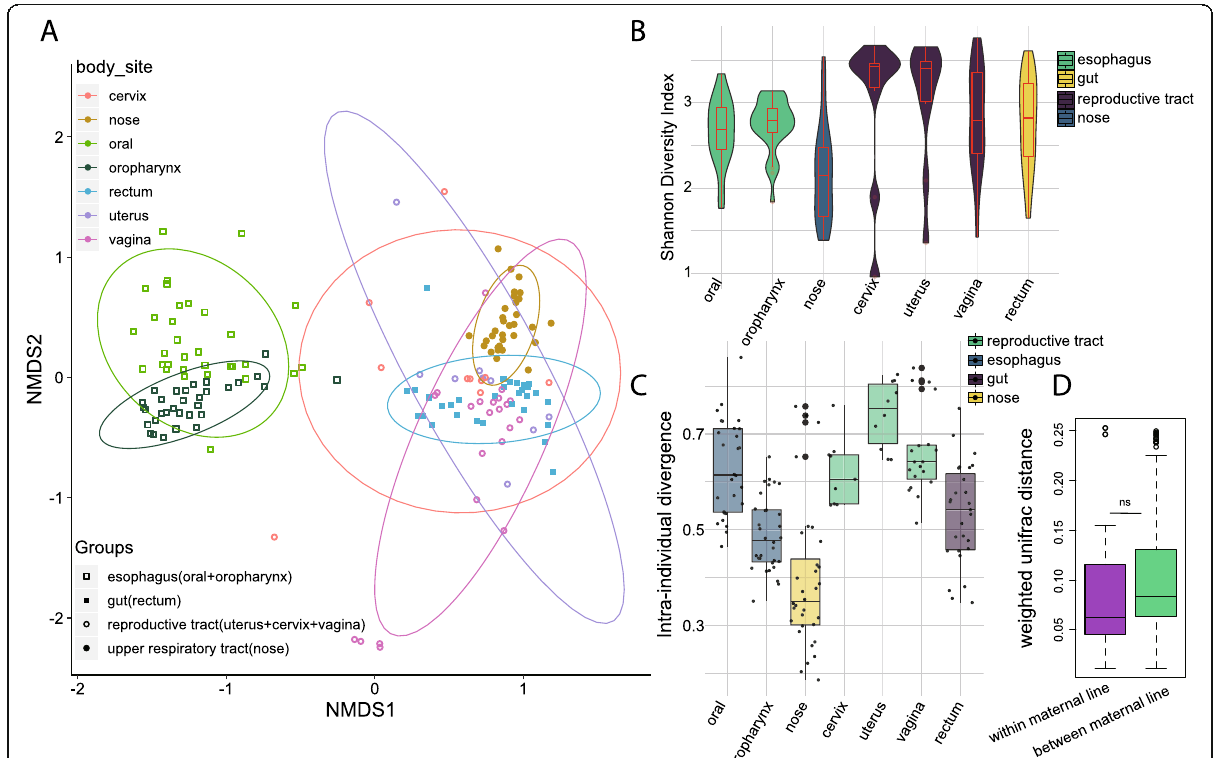
Fig. 2 Microbial characterization in different body sites. a Non-metric multidimensional scaling (NMDS) based on Bray-Curtis distance of microbial communities from the baboon oral cavity, oropharynx, nose, cervix, uterus, vagina and rectum. The colored lines surrounding each sample type are covariance ellipsoids. b Alpha diversity in different body habitats, grouped by area, as measured using the Shannon index of ASV-level bacteria. Pharynx and nose had a significantly lower diverse microbiota than reproductive tract (TukeyHSD). c Divergence of microbes in a specific body site was quantified as the average dissimilarity of each sample from the group mean. d Weighted Unifrac distance within and between maternal lines for gut microbiota. ns means no significant difference detected between the same maternal line and different maternal lines by t-test ( p =